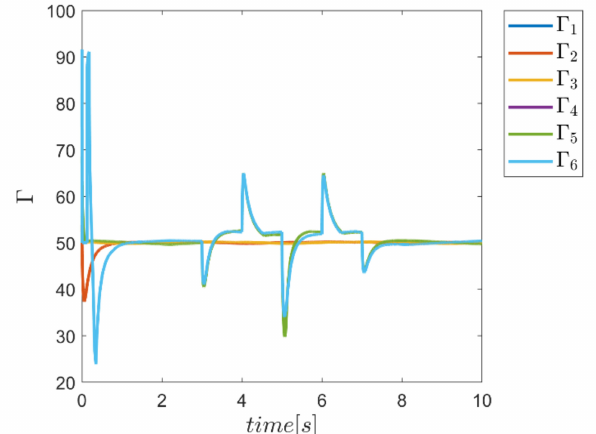
Figure 26. Adaptive variation of the coefficents of Γ for the combined α and Γ fuzzy system.